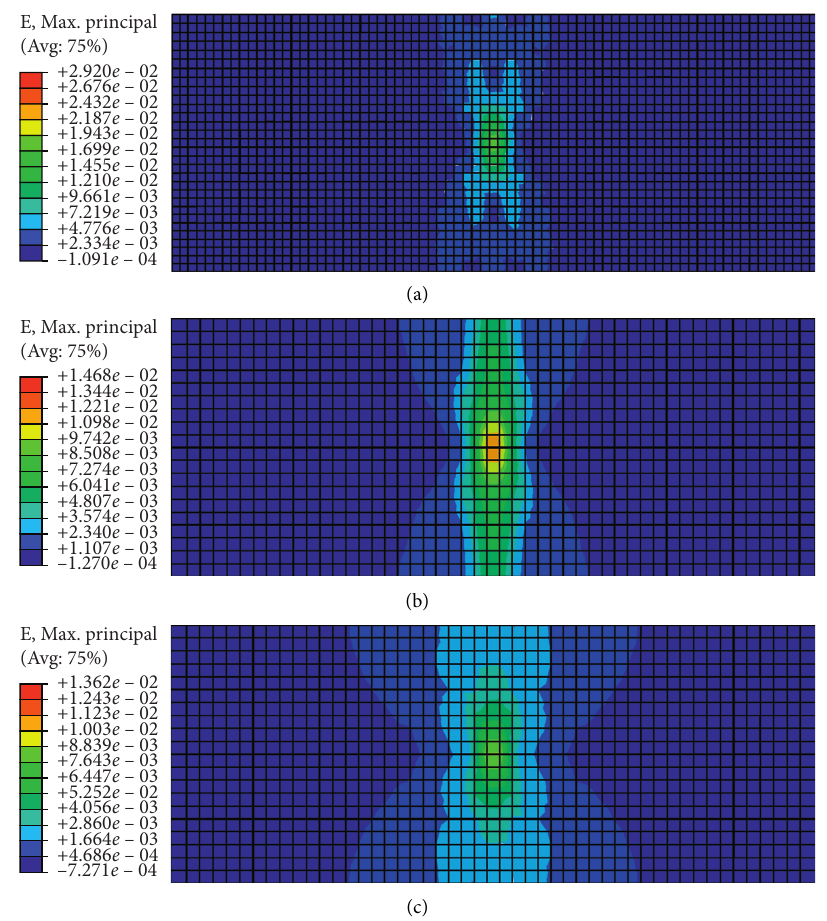
Figure 12: Principal tensile strain contour plots of UHPC in ultimate states: (a) CB-1, (b) CB-2, and (c) CB-3. Table 6: Nominal tensile stress of the model beams. Beam Cracking strain ( µε